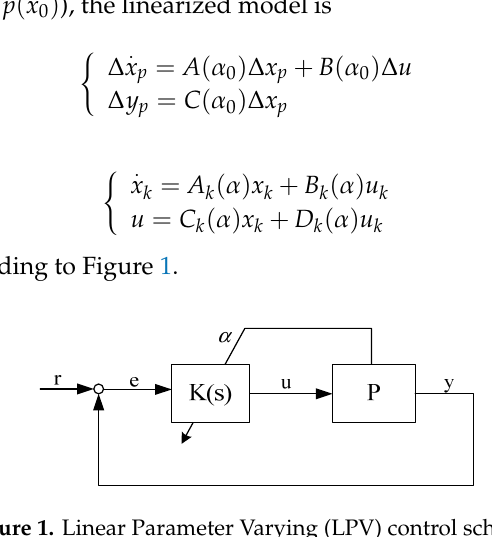
Figure 1. Linear Parameter Varying (LPV) control scheme.